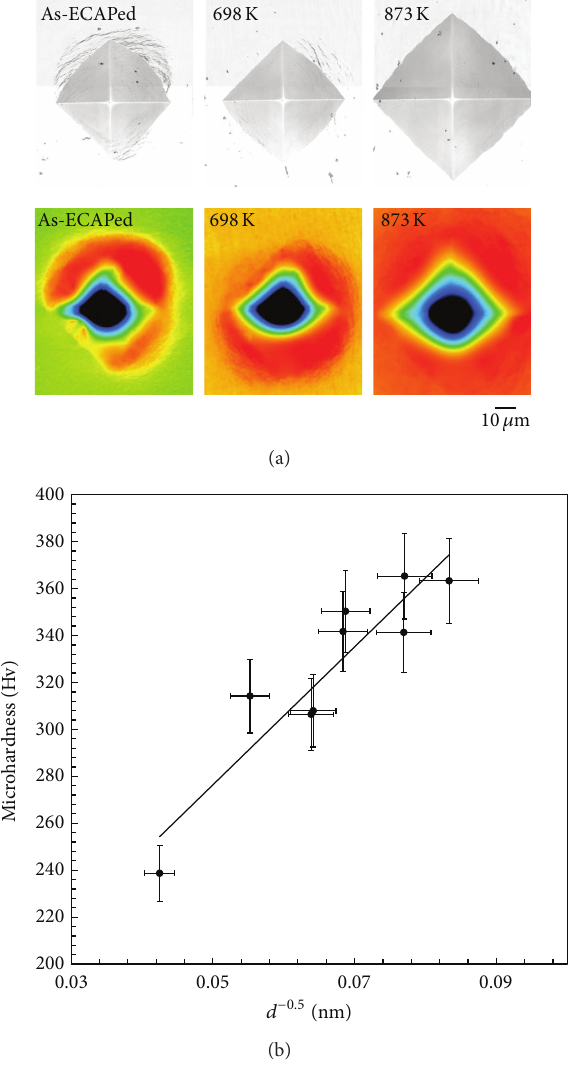
Figure 6: (a) Indenter appearance of Vickers hardness and (b) relationship between hardness and grain size.